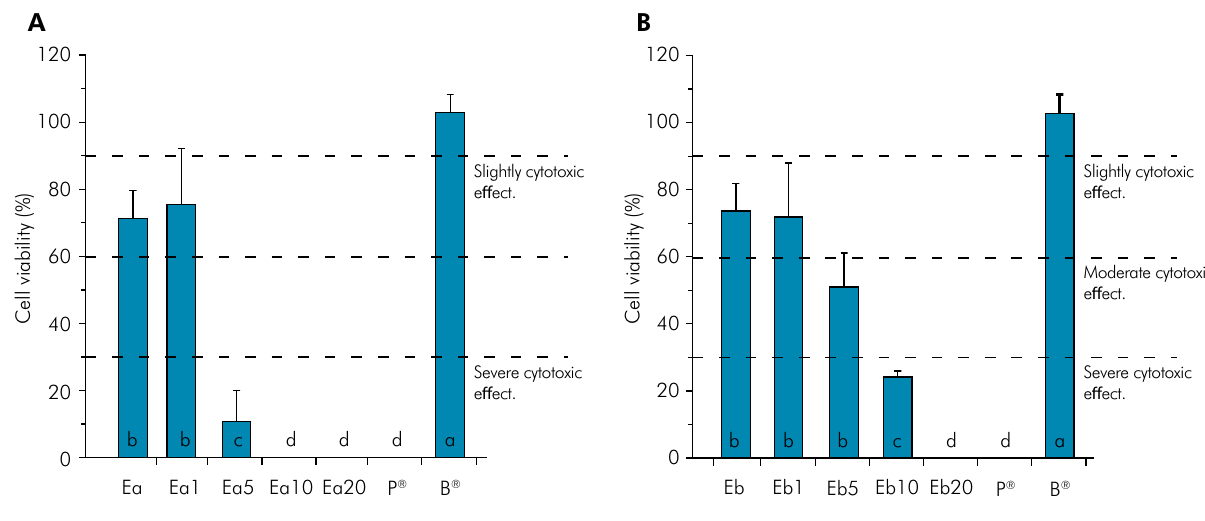
Figure 3. Cell viability of L929 fibroblasts after exposure of eluates to different periodontal dressings. Different lowercase letters indicate statistically significant differences among groups (p < 0.001). Dotted lines indicate the percentages of cell viability considering a material to exert a slight (<90%), moderate (<60%) or severe (<30%) cytotoxic